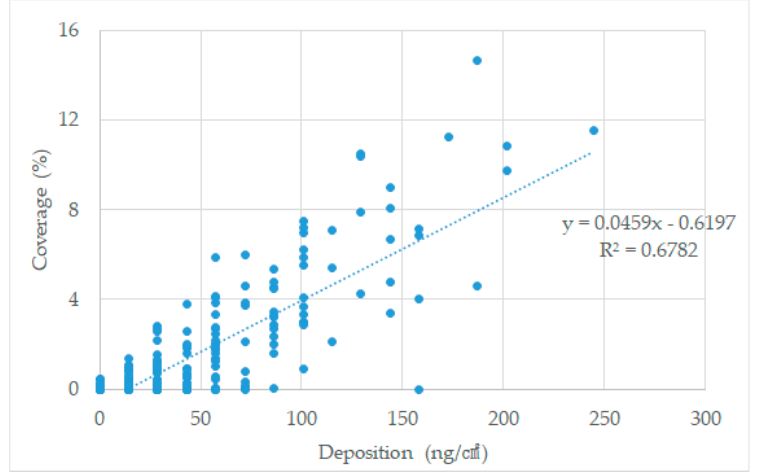
Figure 6. Correlation analysis between amounts of tracer from extration and coverage from image analysis.